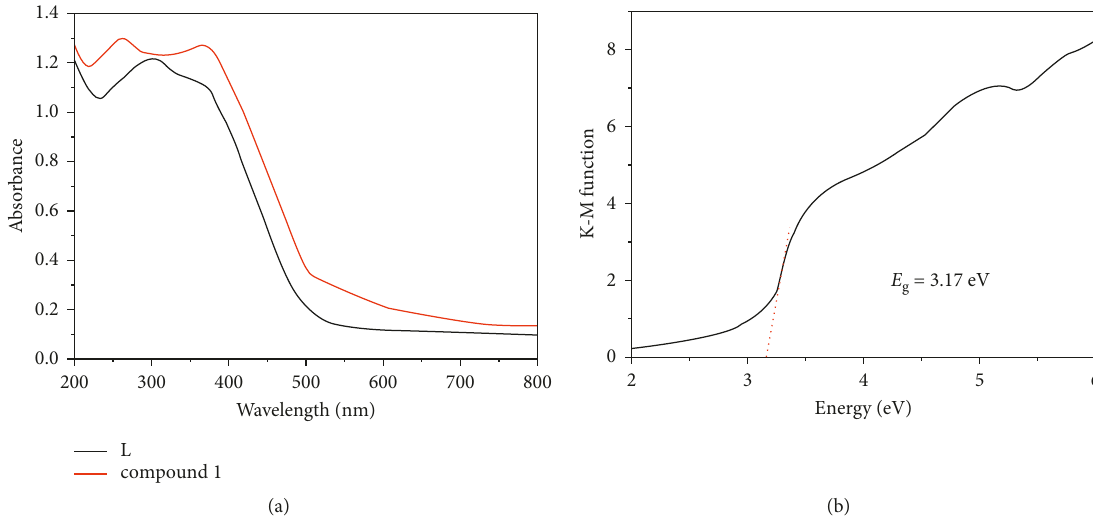
Figure 3: (a) The ultraviolet-visible absorption spectra of free L ligand and complex 1 at RT. (b) Diffuse reflectance spectrum of Kubelka–Munk functions versus energy (eV) for 1